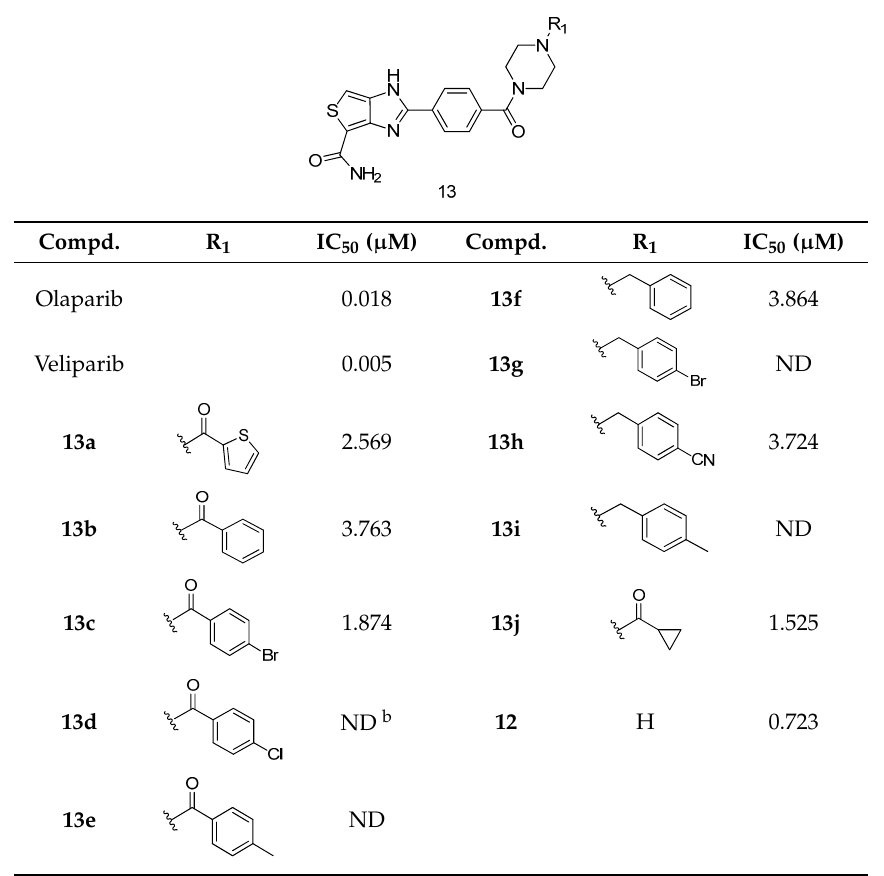
Scheme 2. Synthetic route for target compounds 16a – n . Reactions and conditions : ( a ) i) 1,4-dioxane; ii) Table 1. Structure and PARP-1 enzyme inhibitory activity of compounds 12 and 13a – j . a